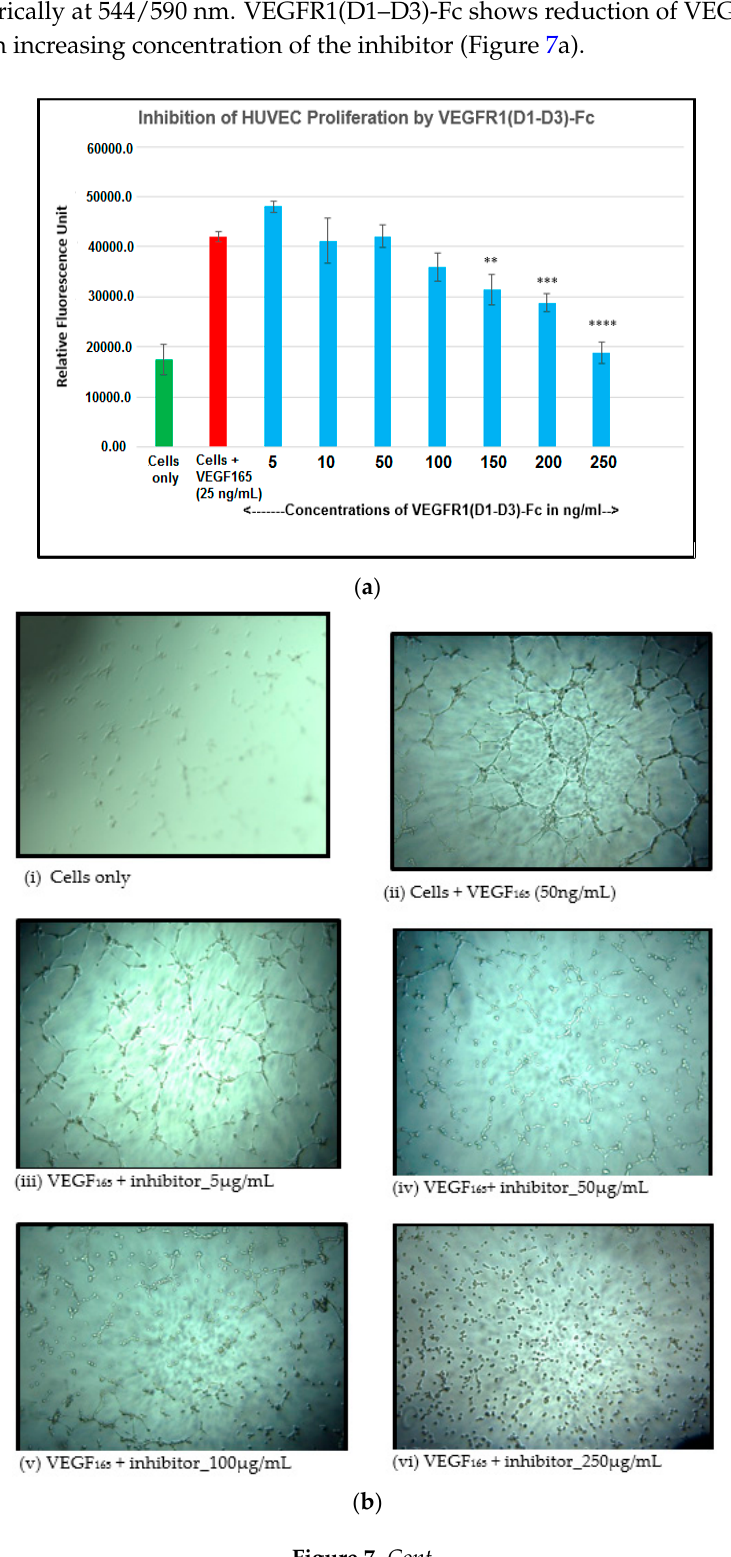
Figure 7. Cont. Figure 7.